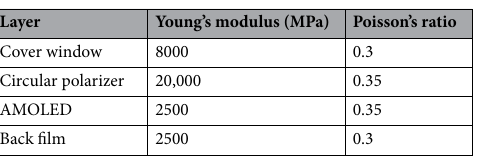
Layer Young’s modulus (MPa) Poisson’s ratio Cover window 8000 0.3 Circular polarizer 20,000